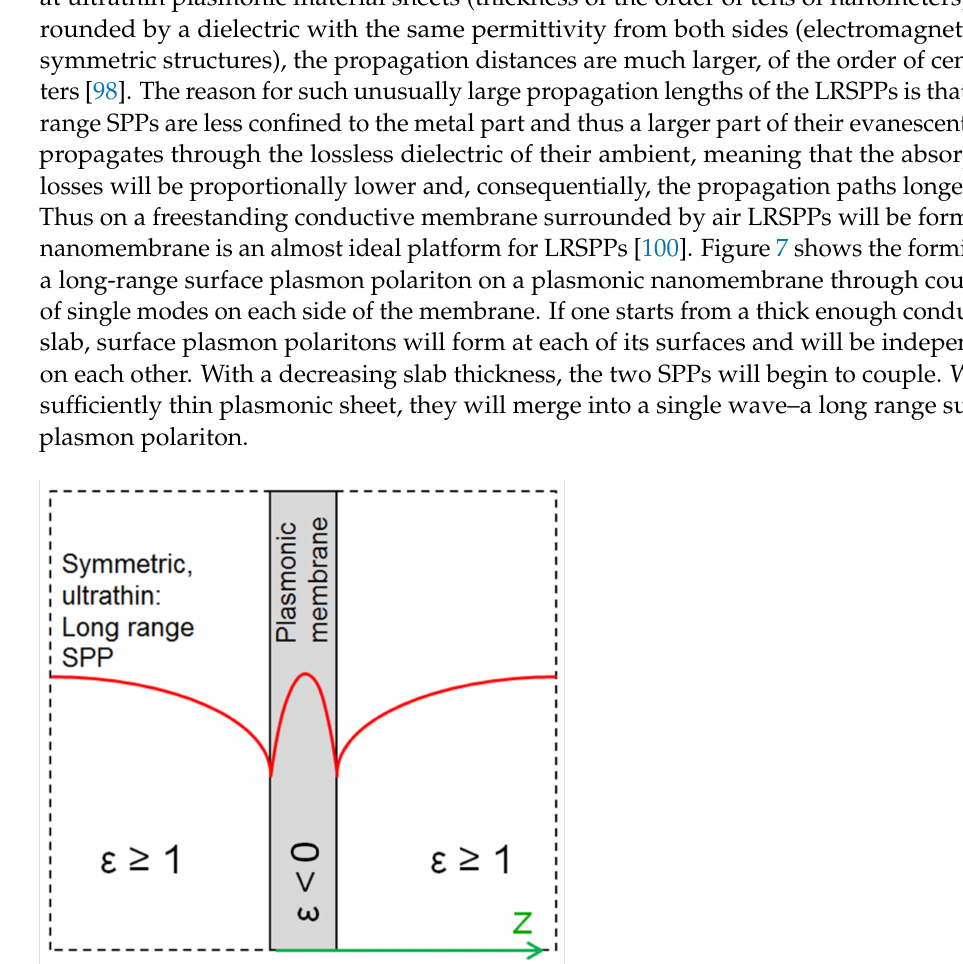
Figure 7. Illustration of the forming of an LRSPP supermode by coupling two surface modes on the surfaces of a plasmonic